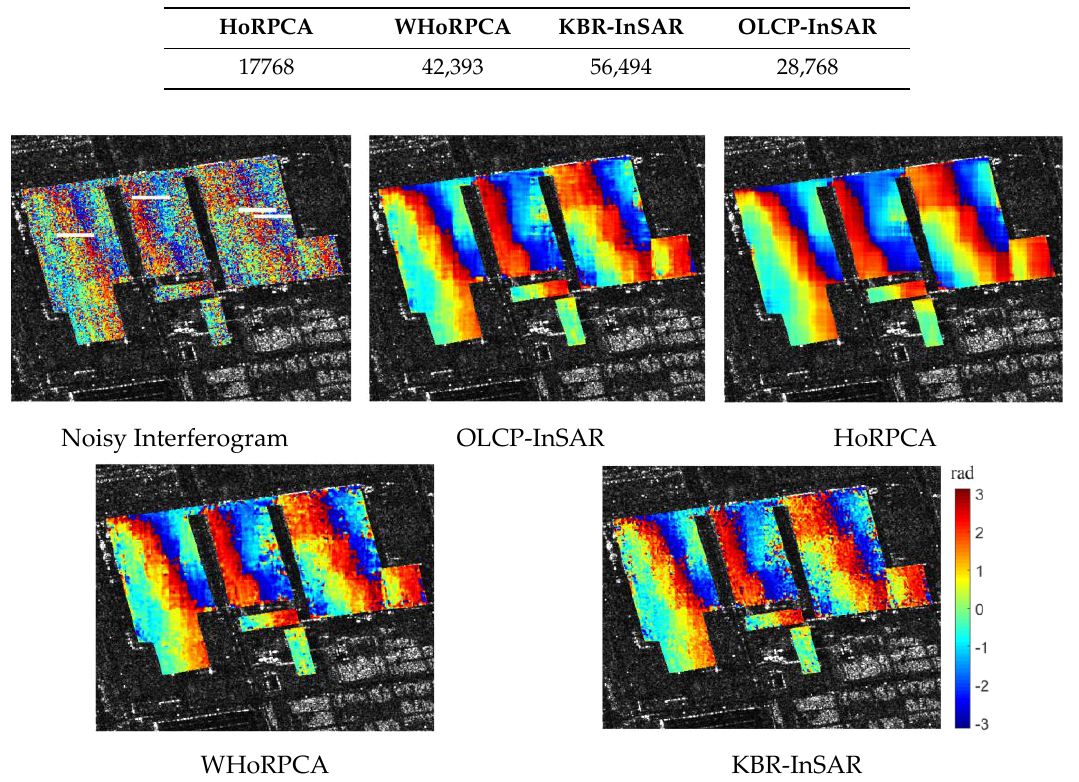
Figure 15. The filtered results acquired by OLCP-InSAR and other filters based on tensor decomposition. The white short line on the noisy interferogram is the selected profile and the filtered results of these profiles are shown in Figure 16. Table 5. Residues remaining in the filtered real InSAR tensor.